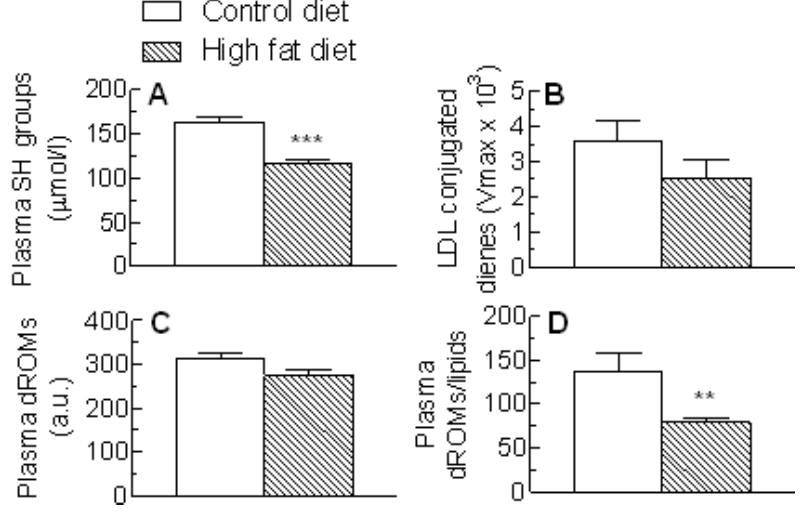
Figure 5. Blood oxidative stress markers in rats fed a standard low fat (Control diet) or a high fat diet for 18 weeks. Blood samples were collected and the plasma or LDL (conjugated dienes formation in response to copper oxidation) content of ( A ) protein thiol ( SH) groups; ( B ) conjugated dienes ( V × 10 3 of propagation phase, determined using max 50 μg/mL LDL protein); ( C ) reactive oxygen species (dROMs) was determined. ( D ) dROMs/plasma lipids. Data are the mean from 6 (control diet) or 9 (High fat diet) animals (protein SH groups and dROMs). For conjugated dienes the mean of 5 rats in each group are shown. Error bars show the SEM. ** P < 0.01, *** P < 0.001 vs. Control